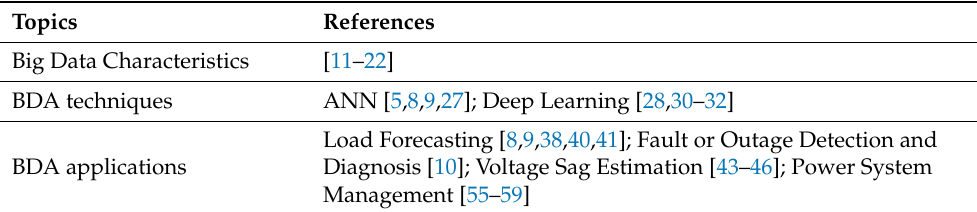
Table 1. A list of key references in the paper.